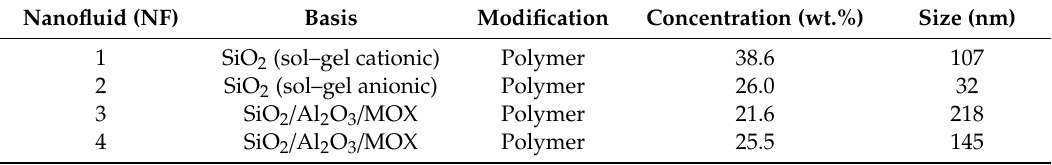
Table 1. Properties of concentrated solutions of silica nanoparticles (NPs) in distilled